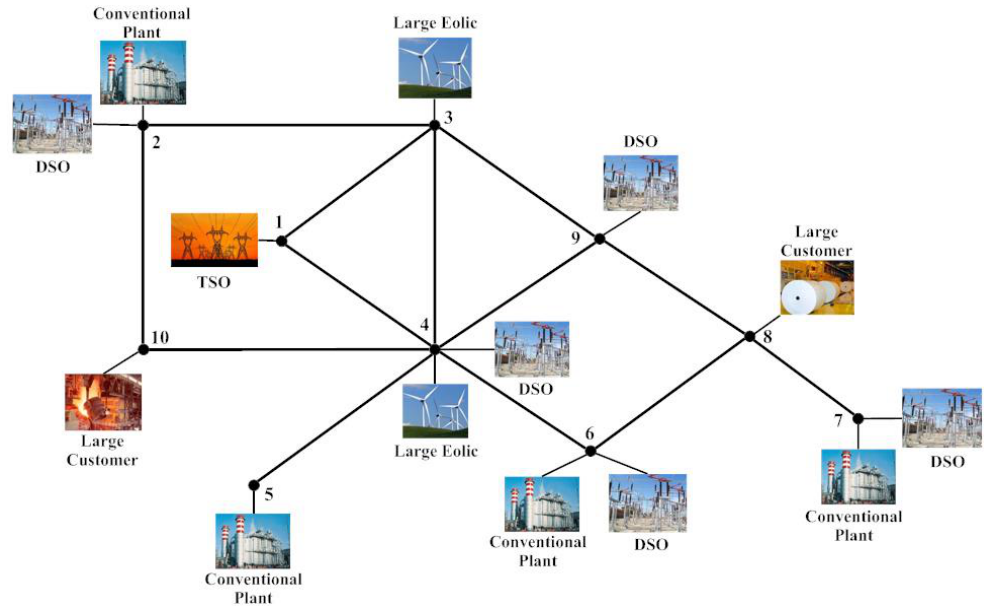
Figure 3. Revisited Cigré 10 node transmission test network layout and node injection characterization. DSO, Distribution System Operator; TSO, Transmission System Operator.